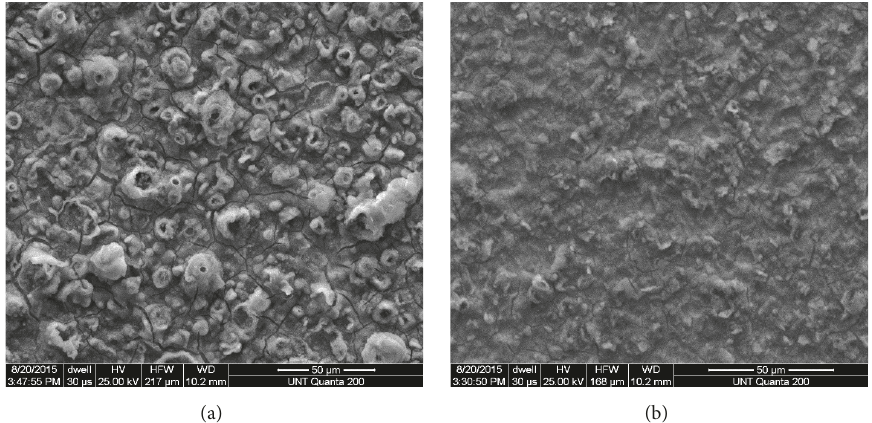
Figure 8: SEM images of HAp coatings electrochemically deposited onto CoCrMo alloy with (a) 0mM aspartic acid and (b) 10mM aspartic acid. (Courtesy I. Coskun and T.D. Golden, 2018).